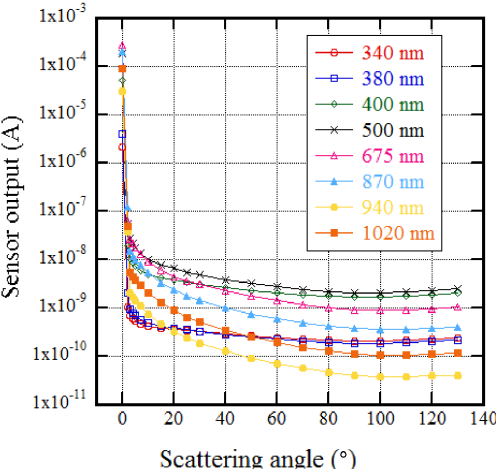
Figure 1. An example of sensor output for the solar direct irradi- ances and the scattered sky radiances by